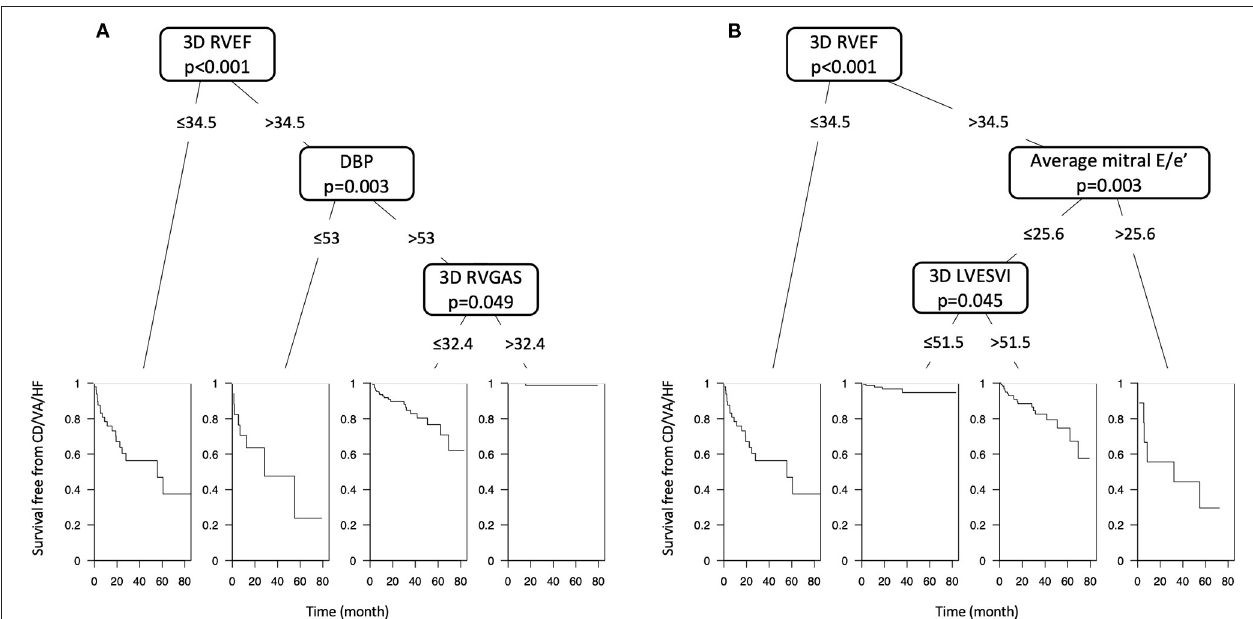
FIGURE 5 | (A) Classification and regression tree (CART) analysis, including twenty-two clinical and echocardiographic parameters. CART selected 3D RVEF (cut-off value: 34.5%) first, followed by DBP (cut-off value: 53 mmHg) and 3D RVGAS (cut-off value: 32.4%), resulting in classification into two high-risk groups ( n = 67), one intermediate-risk group ( n = 154), and one low-risk group ( n = 120). (B) CART analysis, including fifteen echocardiographic parameters. CART selected 3D RVEF (cut-off value: 34.5%) first, followed by average mitral E/e’ (cut-off value: 25.6) and 3D LVESVI (cut-off value: 51.5 mL/m 2 ), resulting in classification into two high-risk groups ( n = 59), one intermediate-risk group ( n = 126), and one low-risk group ( n = 156).